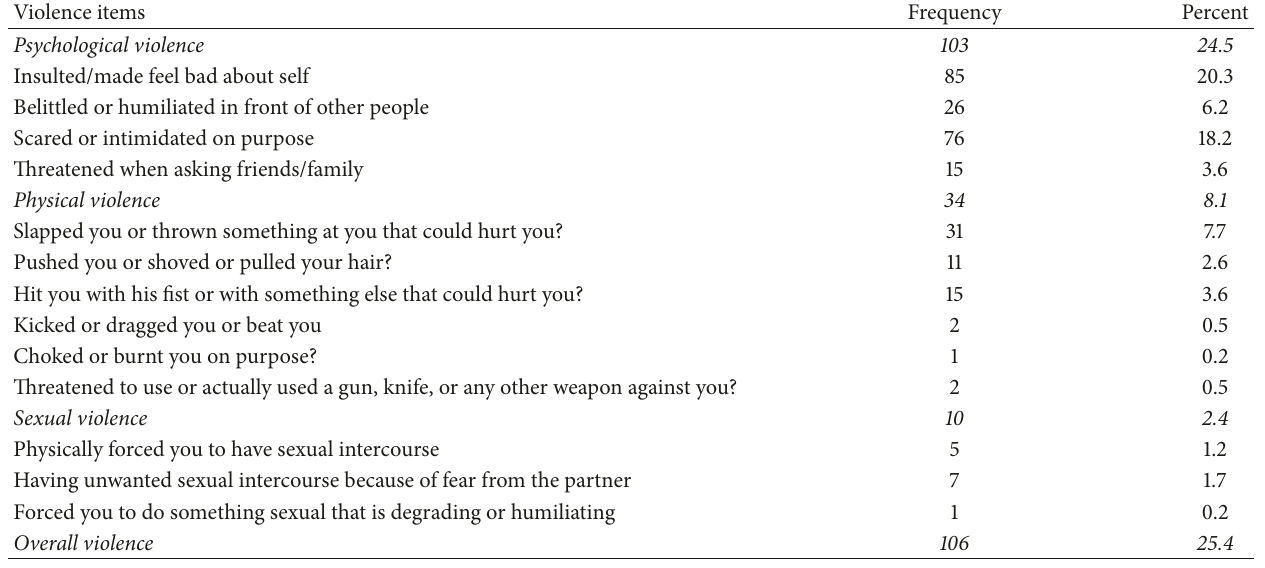
Table 3: Frequencies of domestic violence toward each item of WHO tools in Gondar town, 2015 (𝑛 = 418) . Violence